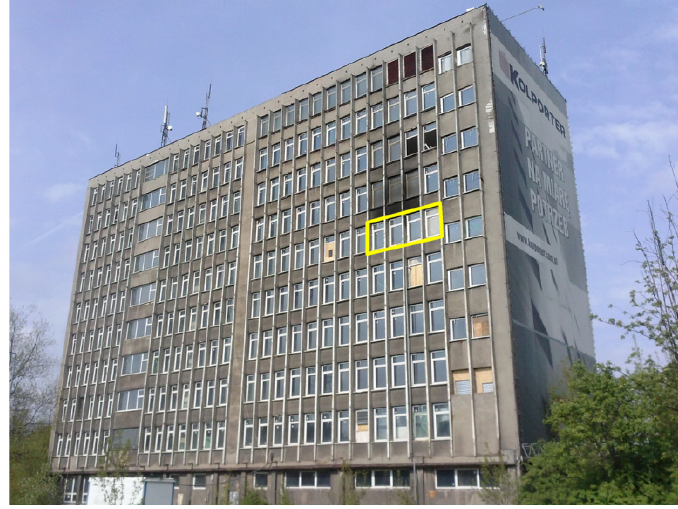
Figure 1. View of the building with the test room marked (on the west façade).